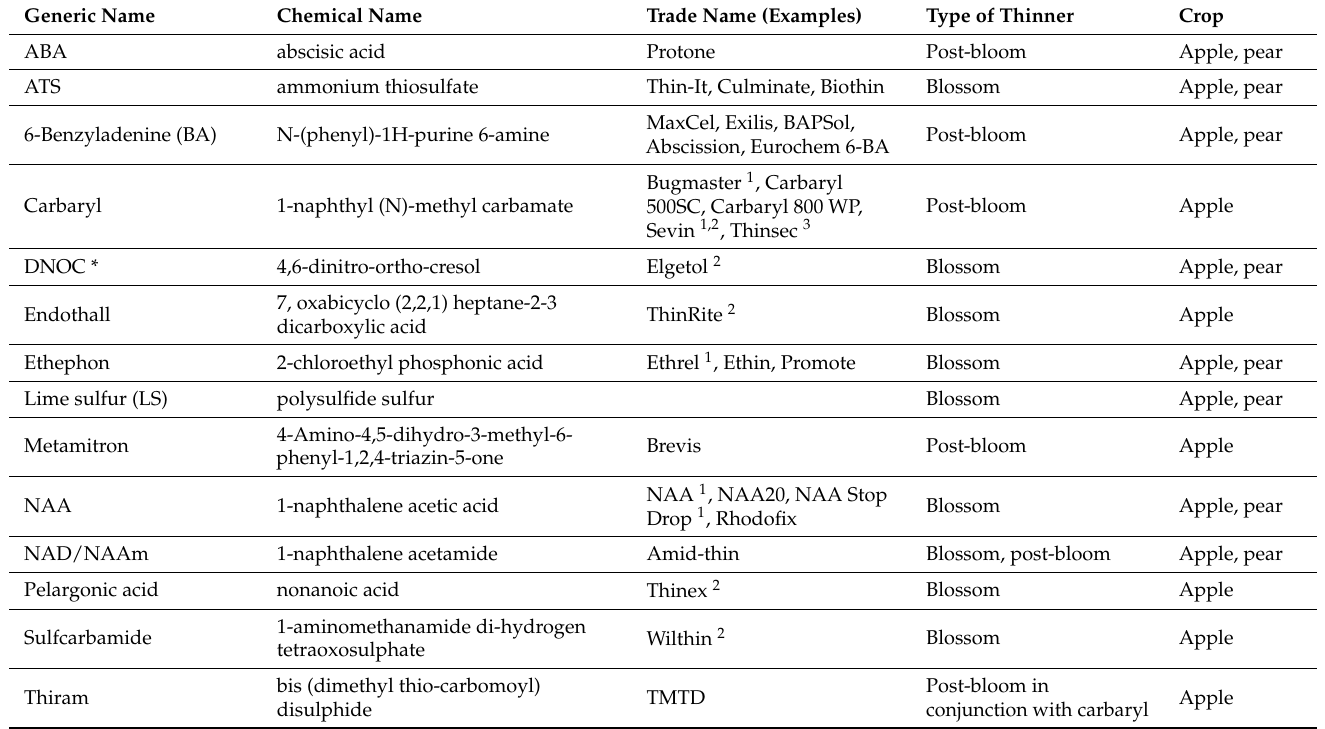
Table 6. Chemicals used worldwide for the thinning of pomes (Source: Bound